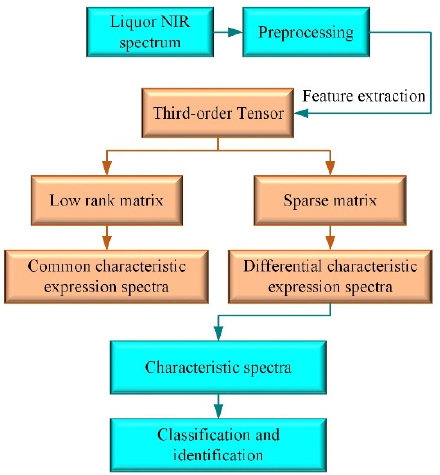
Figure 2. An illustration of NIR spectrum processing sequences used for liquor identification.